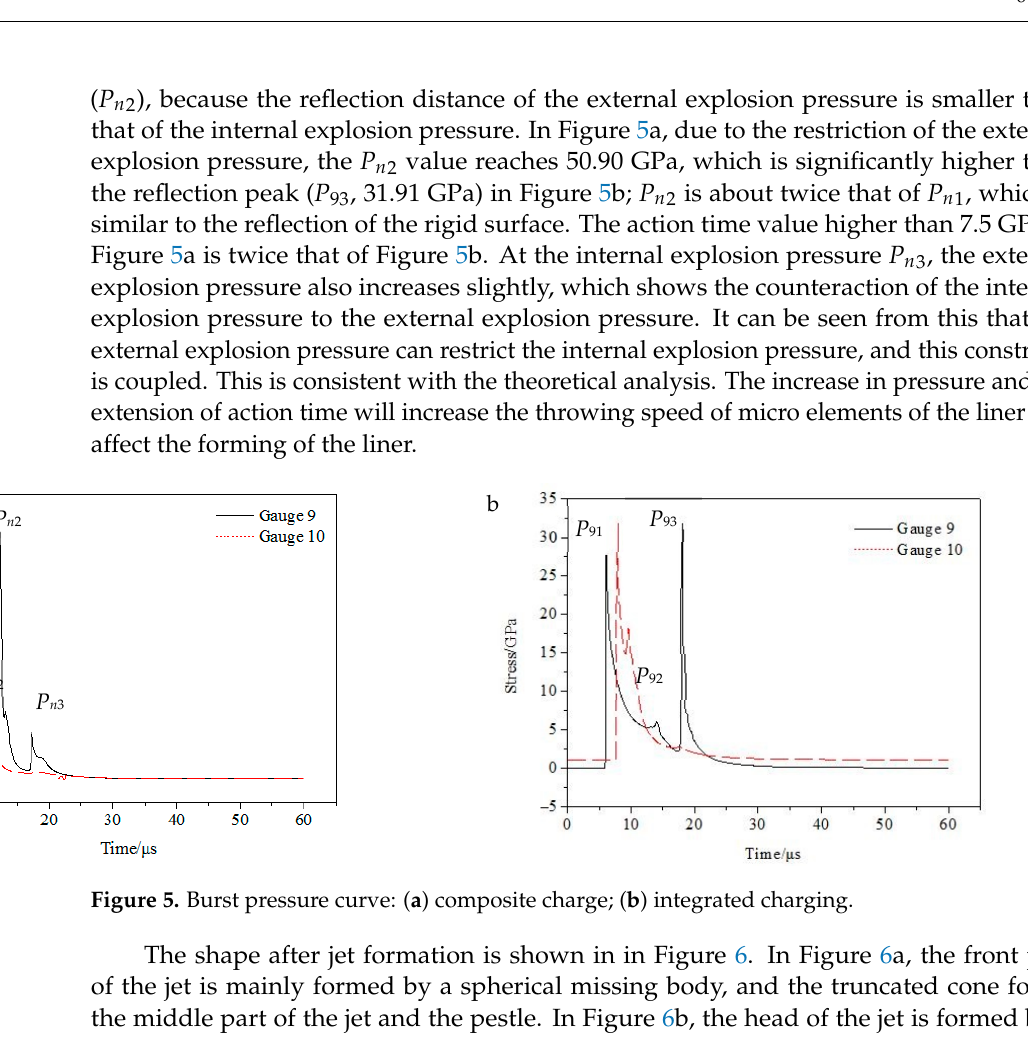
Figure 4. Numerical simulation model: ( a ) composite charge; ( b ) integrated charging.